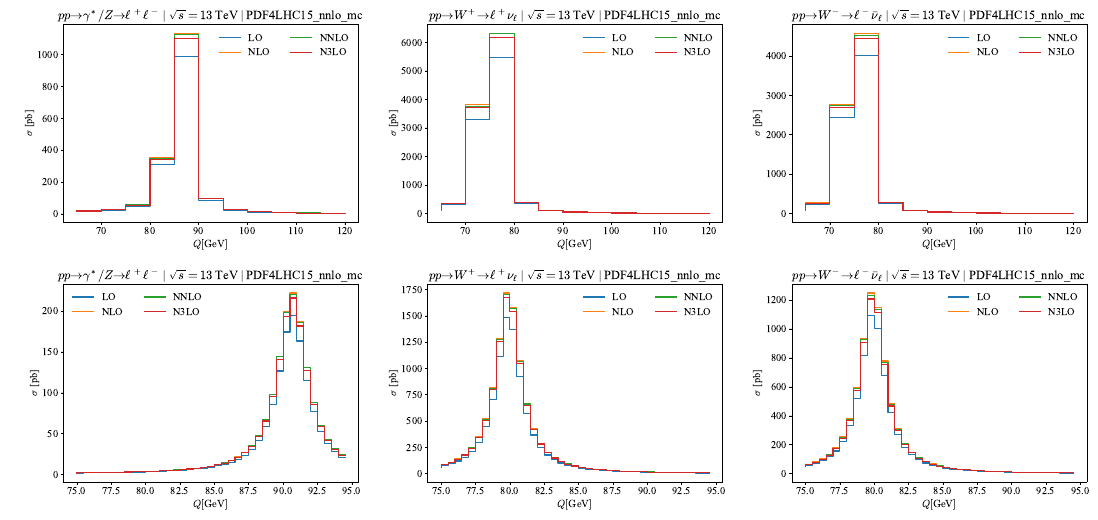
Figure 20 . The invariant-mass distribution around the Z or W -peak for the neutral- and charged- current Drell-Yan processes at the 13 TeV LHC, in bins of size 5 GeV (upper panels) and 0.5 GeV (lower panels) respectively. Note that the y -axis on the upper panel is